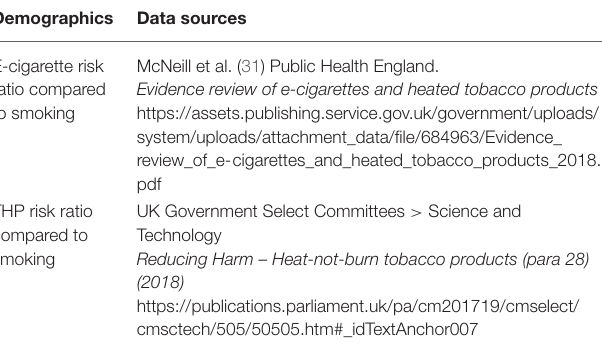
TABLE 2 | Two-product model data